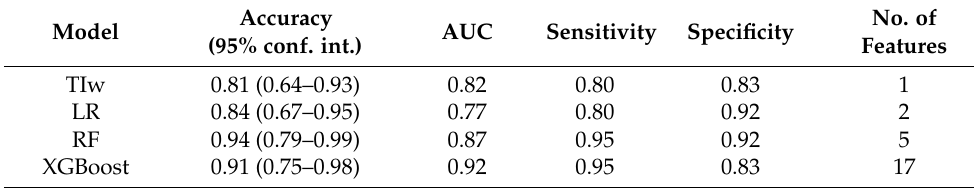
Figure 3. ROC curves ( a ) and calibration curves ( b ) from LOO-CV of TIw ROC (AUC = 0.82), Logistic Regression (AUC = 0.77) and optimal models with the best hyperparameters tuning: Random Forest (AUC = 0.87) and XGBoost (AUC = 0.92). Classification accuracies (with a 95% confidence interval), AUCs, sensitivities, spec- ificities and the optimal number of variables for each ML model are reported in Table 3. Table 3. Classification performances of ML models.